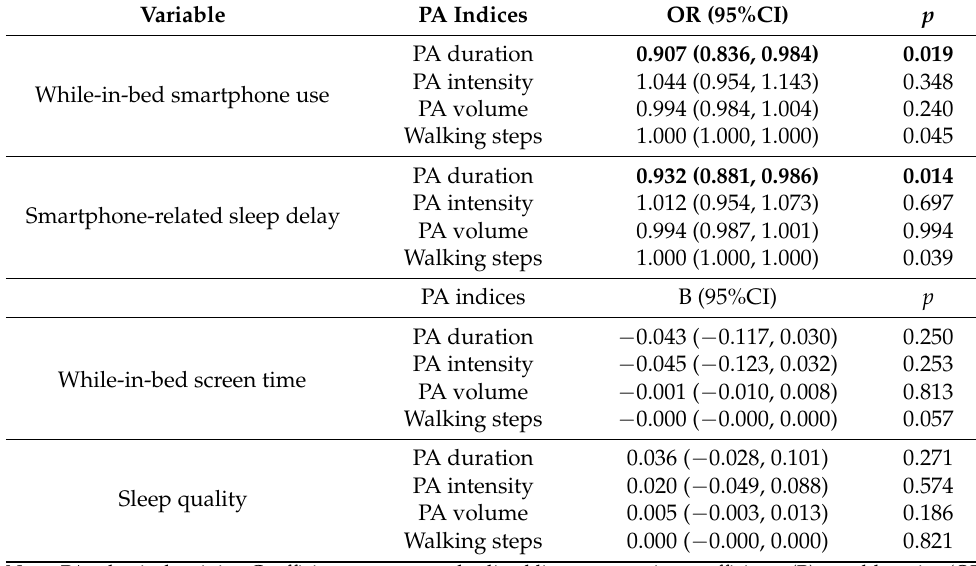
Table 3. The associations between PA items and variables of